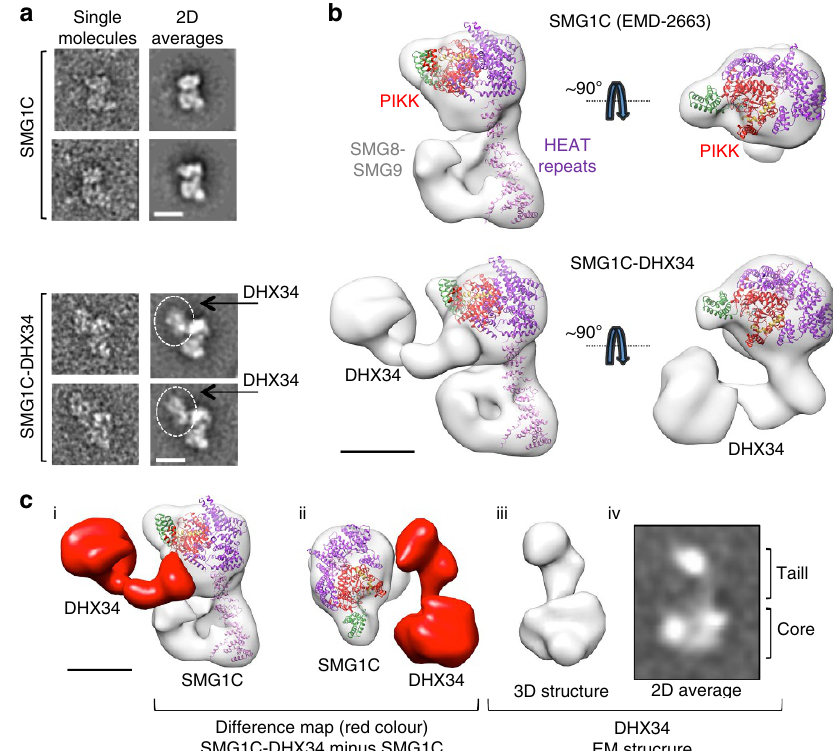
Figure 3 | Architecture of the SMG1C–DHX34 complex. ( a ) A gallery of two representative images of SMG1C and SMG1C–DHX34 molecules, and two representative two-dimensional (2D) averages of SMG1C and SMG1C–DHX34. The images revealed SMG1C structured into a compact head (at the top of each molecule in these panels) and a thin arm (at the bottom of each molecule in these panels), similar to those described before 21 . DHX34 interacts with the head region and its location in the images has been highlighted within a circle. Scale bar, 10nm. ( b ) Two approximately orthogonal views of the EM structures (grey transparent density) of SMG1 (EMD-2663) 21 (top panels) and SMG1C–DHX34 (bottom panels). A model of SMG1 in each complex was obtained by fitting a HEAT repeat segment of DNA-PKcs (PDB ID 3KGV) 19 and the catalytic region of mTOR crystal structures (PDB ID 4JSP) 18 , as described before 21 . The putative location of FRB (green), FAT (purple), PIKK domain (red) and HEATrepeats (purple) on that model are indicated, following a previously published model 21 . Scale bar, 5nm. ( c ) Two views (i,ii) of the difference map obtained after subtracting the structure of SMG1C to SMG1C– DHX34. The difference is shown as a solid red density represented on the structure of the SMG1C used for subtraction, with the atomic model fitted within the EM density 21 . A view of the 3D structure (iii) and 2D average (iv) of DHX34 alone is shown for comparison with the structure of DHX34 in complex with SMG1 (i,ii). Scale bar,